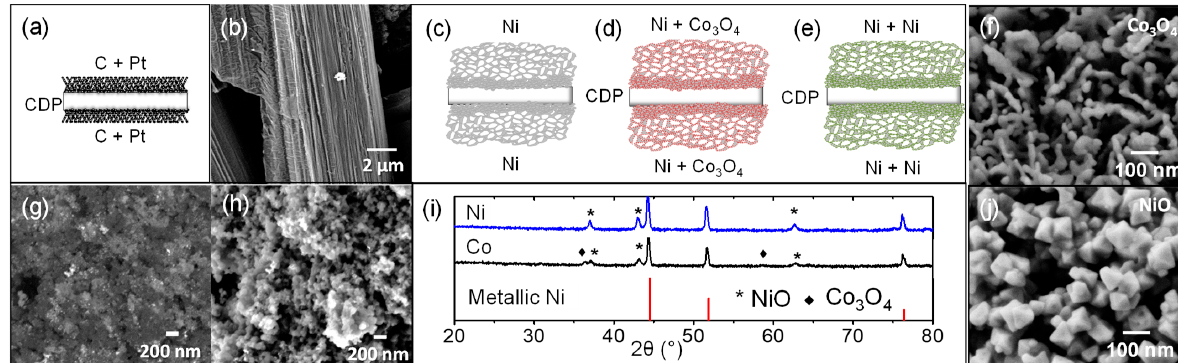
Figure 5. ( a ) Scheme of symmetrical cells supported on the CsH 2 PO 4 electrolyte (CDP) configuration of commercial carbon paper infiltrated with Pt. ( b ) Field emission(FE)-SEM images of carbon fibers of carbon paper scheme of symmetrical cells of ( c ) Ni sponge, ( d ) Ni sponge infiltrated with Ni, and ( e ) Ni sponge infiltrated with CO 3 O 4 as electrodes. ( f ) FE-SEM images of CO 3 O 4 nanoparticles infiltrated in the Ni support. ( g ) Backscattered electrons. ( h ) Secondary electrons FE-SEM images of XC-72 with Pt nanoparticles. ( i ) XRD of nickel support infiltrated with nickel and cobalt oxides and ( j ) FE-SEM image of NiO infiltrated nanoparticles.